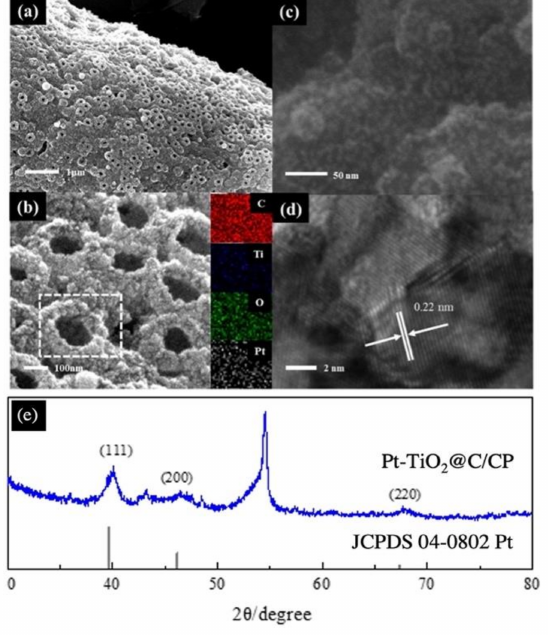
Figure 4. SEM ( a – c ) and TEM ( d ) images and XRD pattern ( e ) of the Pt-TiO 2 @C/CP.